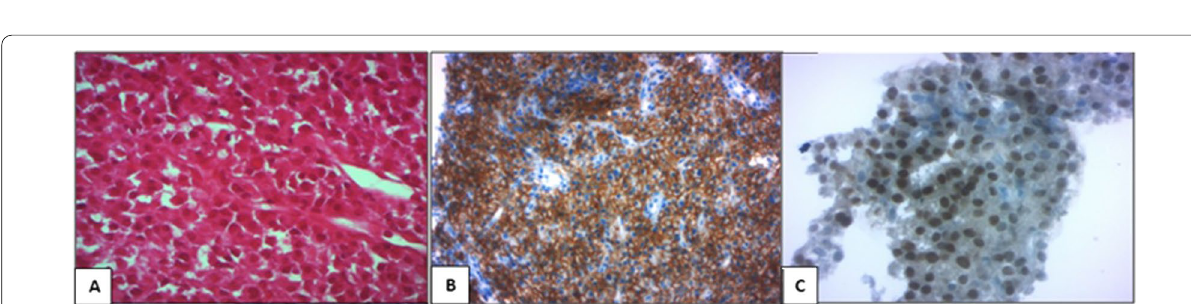
Fig. 2 Microscopic examination of the thymus biopsy showed diffuse infiltrates of plasma cells with large and eccentric nuclei and abundant cytoplasm (H&E 400) ( A ). Immunohistochemistry showed tumor cells with diffuse reactivity to CD138 ( × ( 200) ( C ×